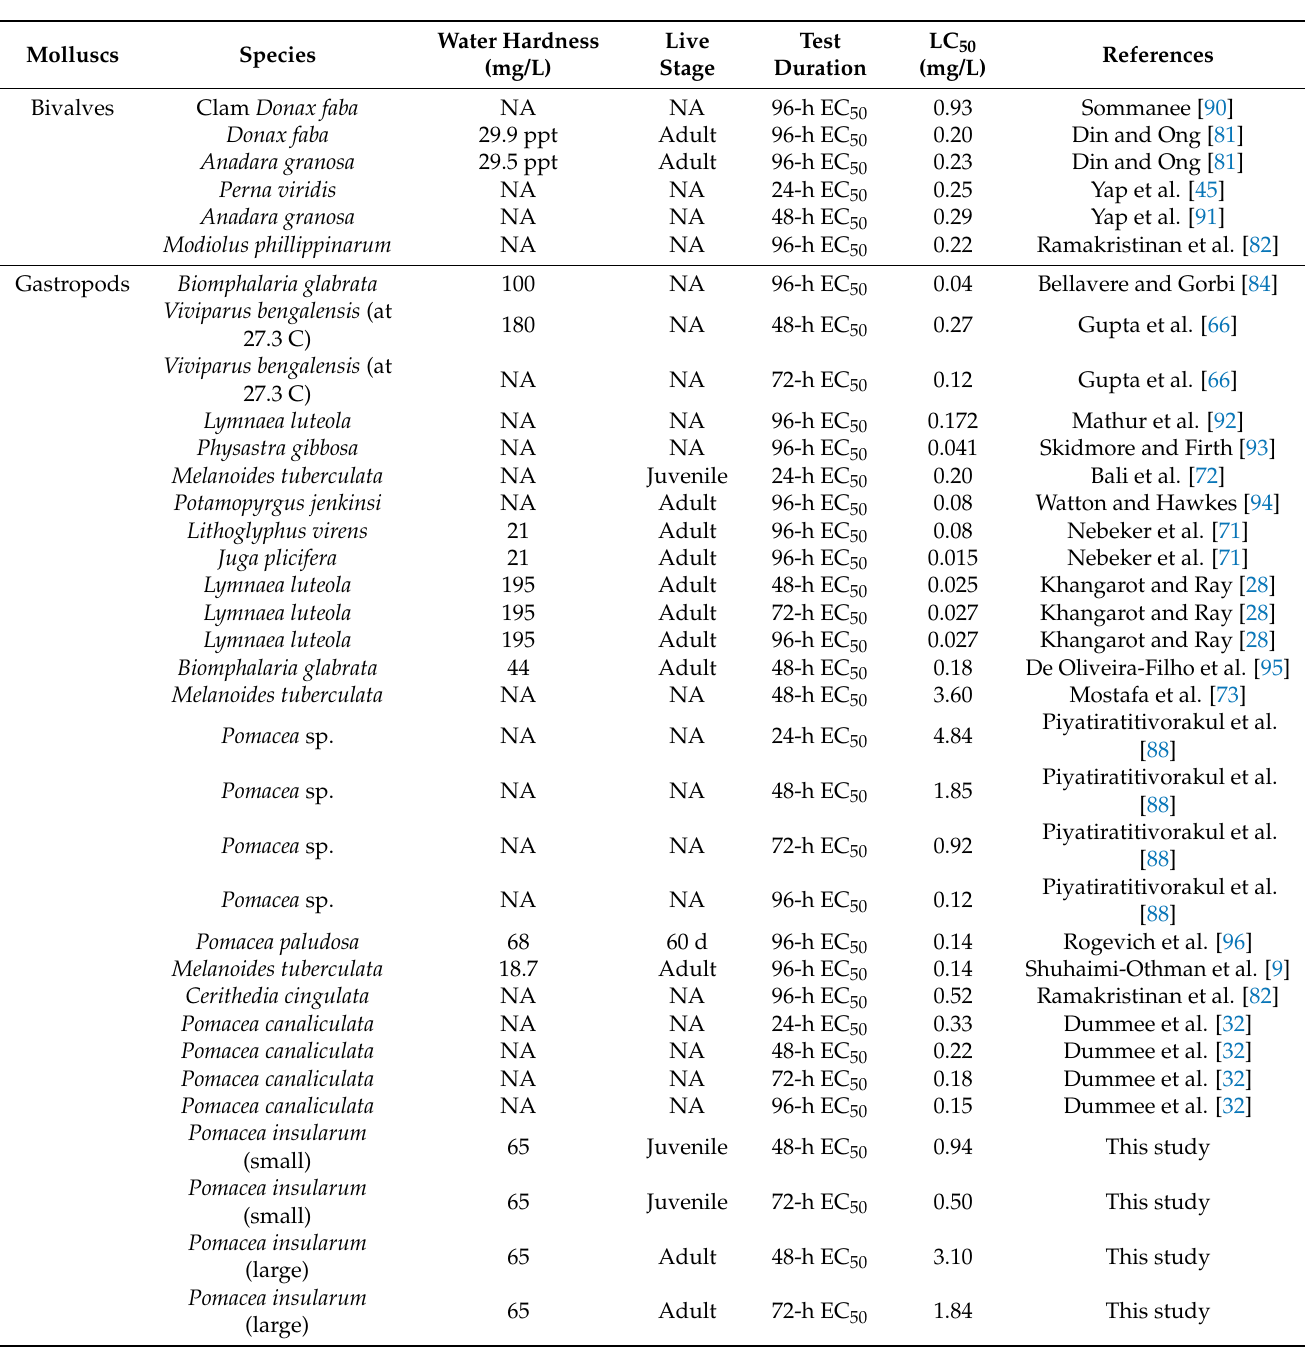
Table 3. Comparison of LC 50 values (mg/L) of Cu in Pomacea insularum with other mollusks reported in the